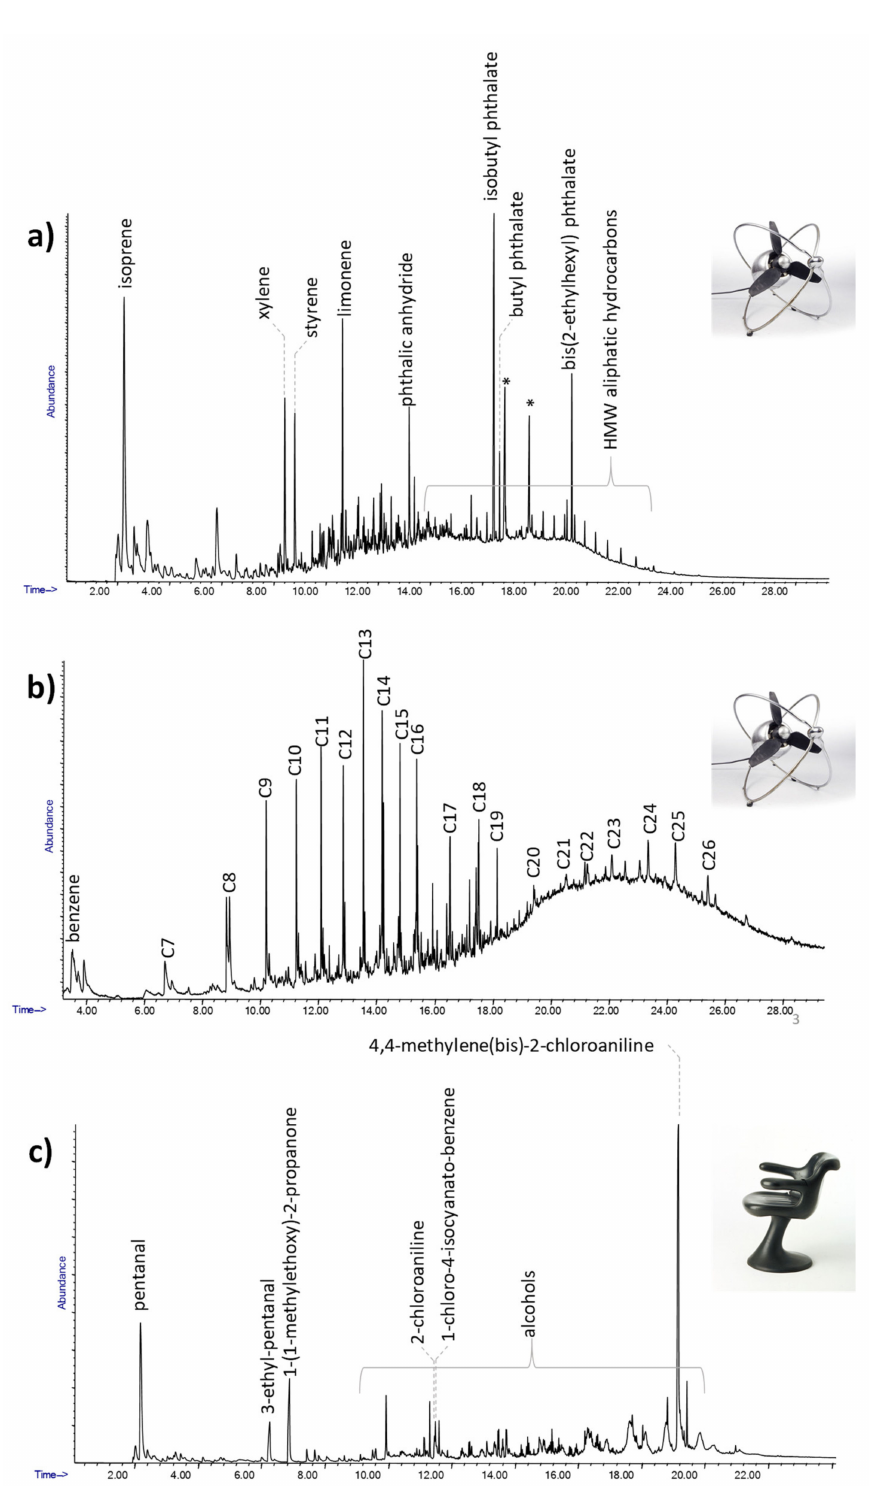
Figure 5. The Py-GC / MS chromatograms obtained for the samples from VE505, ( a ) and ( b ), and IN301 ( c